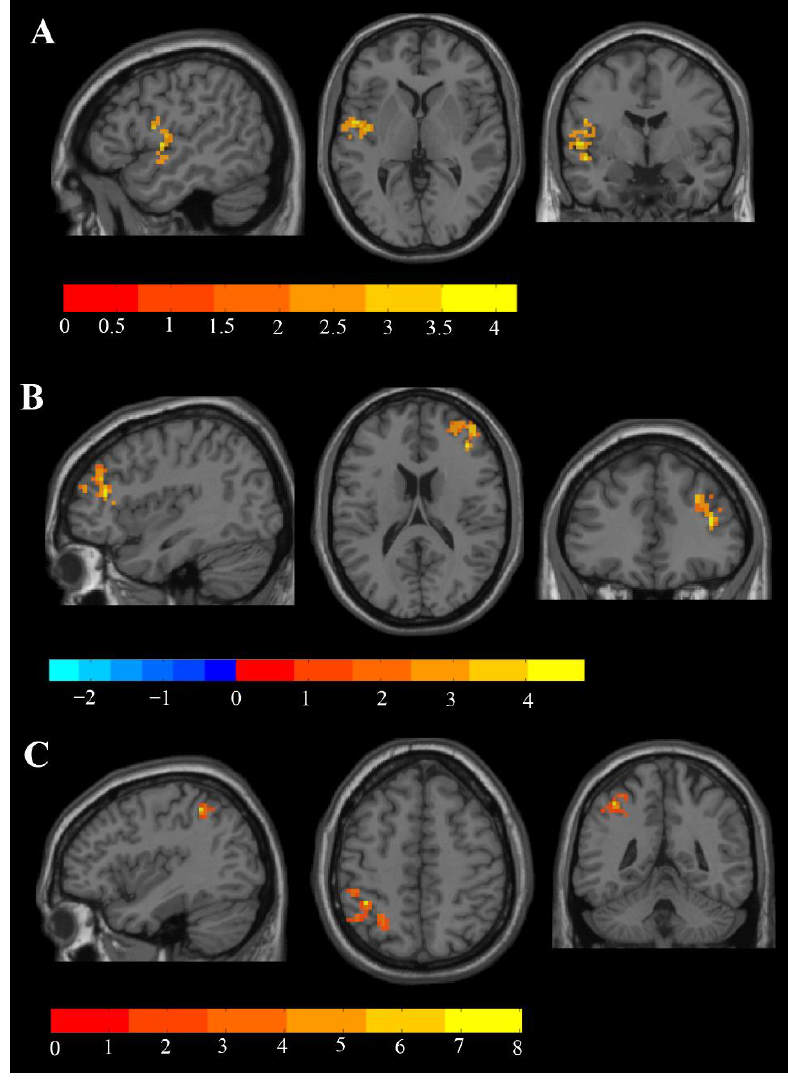
Figure 4. Changes in DC before and after iTBS intervention: ( A ) differences in interhemispheric DC between TP1 and TP2 (paired t -test, p < 0.05, AlphaSim correction, cluster siz e ≥ 1 69 voxels); ( B , C ) differences in DC of whole grey matter between TP1 and TP2 (paired t -test, p < 0.05, AlphaSim correction, cluster siz e ≥ 1 42 voxels). The blue areas represent the regions that have decreased DC values, while the yellow areas represent the regions that have increased DC values.